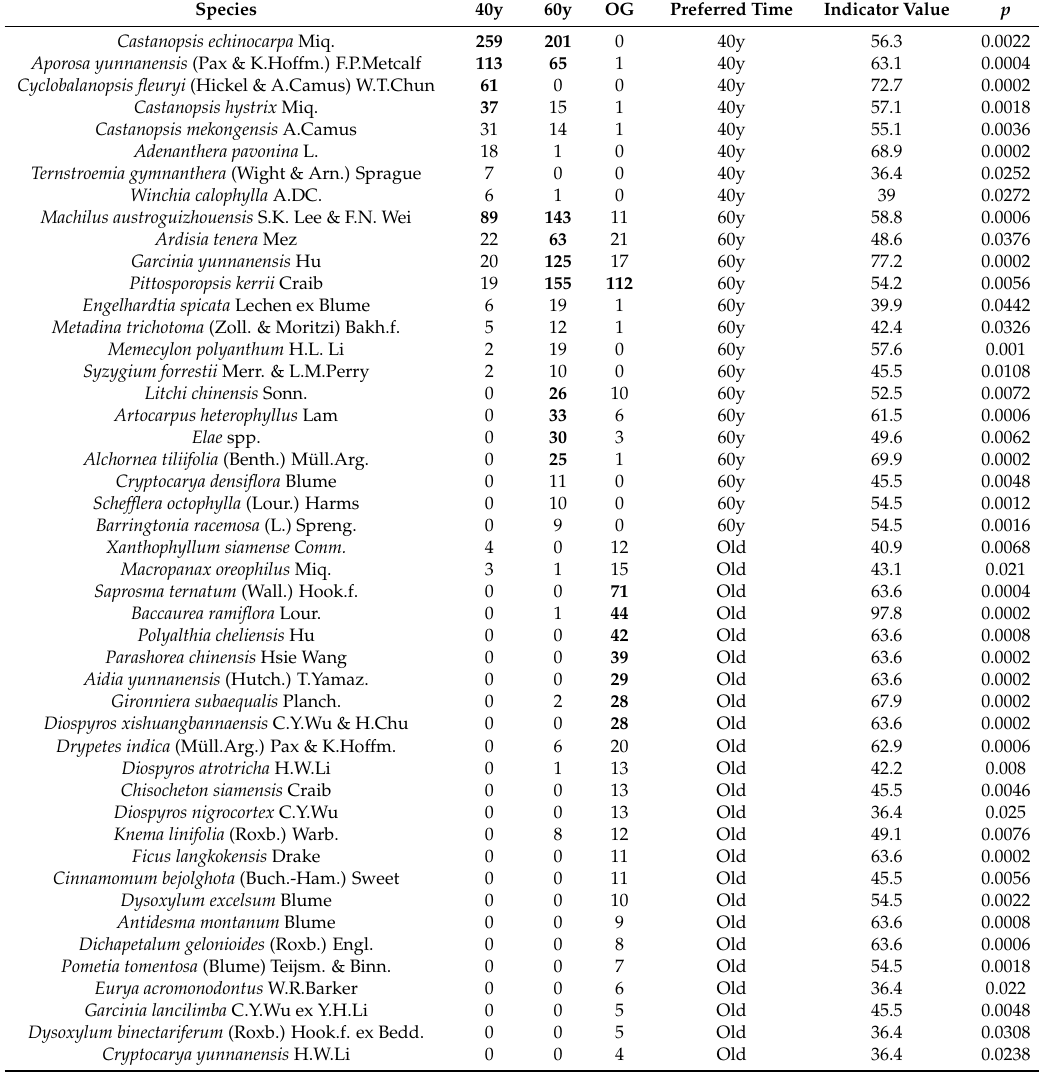
Table A1. Tree species composition for three recovery forests ( p < 0.05): 40-year-old forests (40-year), 60-year-old forests (60-year) and old-growth forest (old). The number of observed stems for each species and the indicator species value were shown. Significant associations with each of the different restored forests were tested using the probabilities of obtaining as great an indicator value as observed over 1000 iterations ( p ). Parameters and abbreviation: 40-year-old forests (40y), 60-year-old forests (60y), old-growth forests